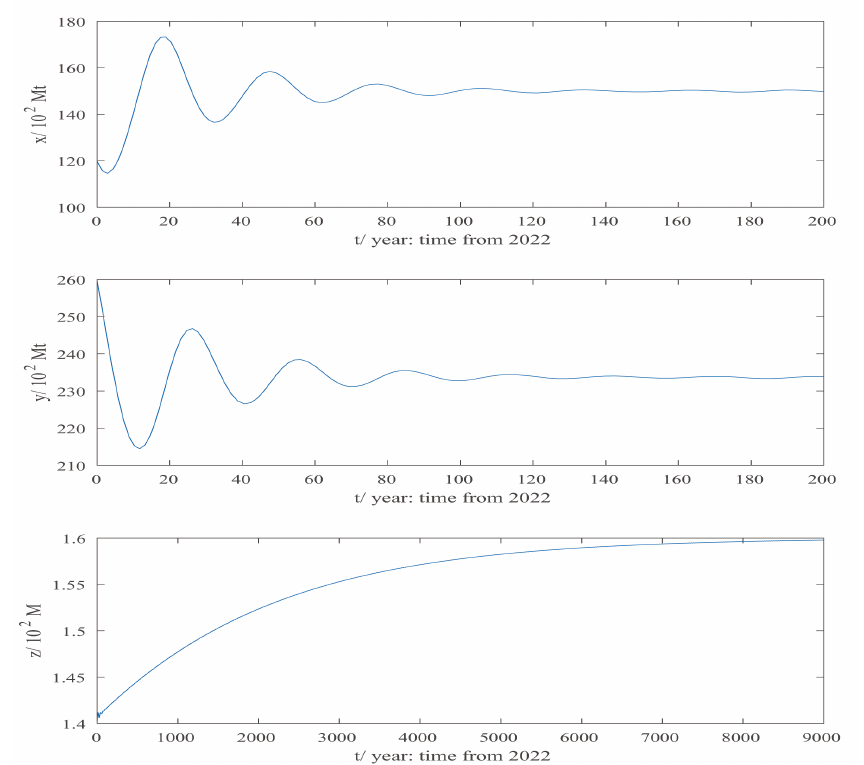
Figure 5. Equilibrium point E ∗ of system (3) is locally asymptotically stable when τ = 0 under the second group of parameters.